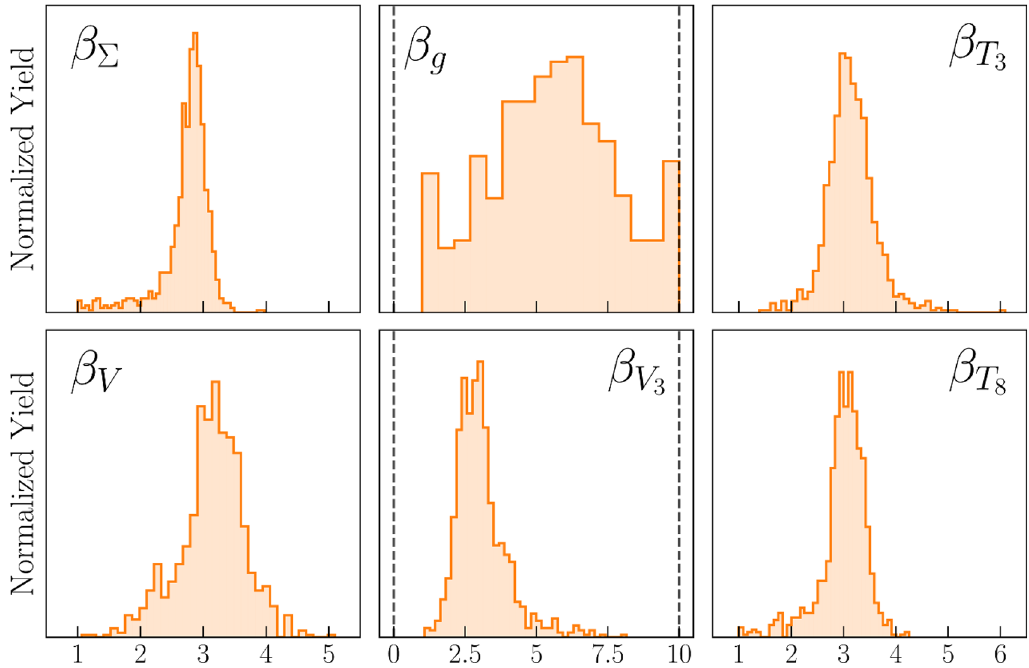
Figure 4 . Same as (cid:12)gure 3 for the (cid:12)tted large- x preprocessing exponents (cid:12) f . Note the di(cid:11)erence in the x -axis range values for each